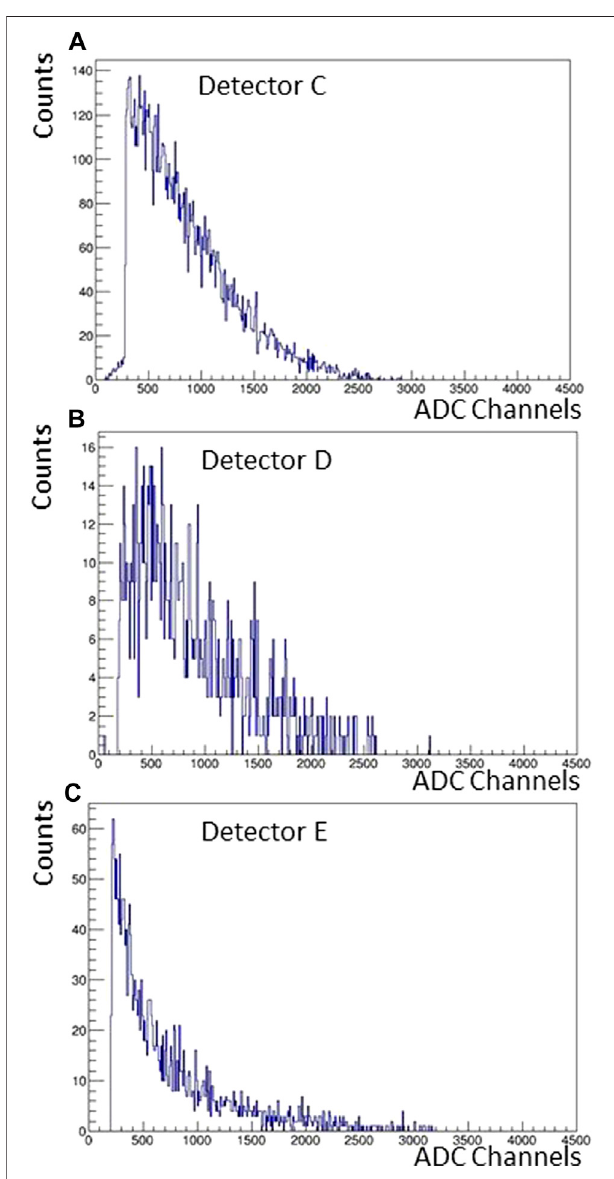
FIGURE 10 | ADC counts histograms obtained for a single run while diamond C (A) , D (B) and E (C) were exposed to 90 MeV FF98. Diamond detectors were biased at − 450 V and side 0 ° was exposed to FF. Its smaller size explains the difference in statistics for detector D. The run for diamond C is twice longer in time than the ones with D and